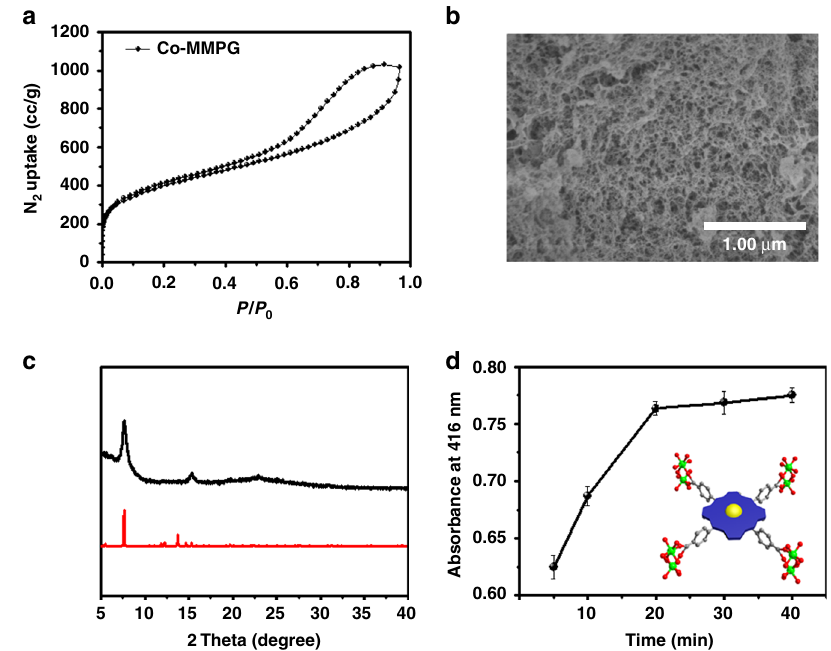
Fig. 2 Structural characterization. a The N 2 sorption isotherms of Co-MMPG at 77 K; b SEM of Co-MMPG after supercritical CO 2 drying; c PXRD patterns: Co-MMPG after activation (up) and calculated from the corresponding MOF stucture; d monitoring the formation of porphyrin – Al cluster in the ethanol solutions of Co-TCPP and Al(NO 3 ) 3 by UV – vis spectra (the optical density at 415 nm slowly goes up within the increase of time). The S.E.M. bar represents the standard deviation from the repeated experiment after three times. Source data are provided as a Source Data fi